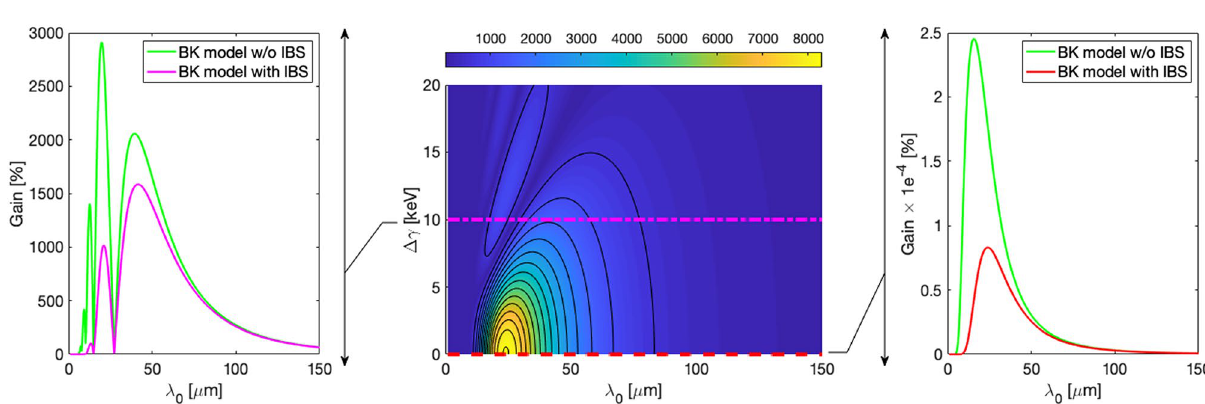
Figure 3. Same as in Fig. 2, but now the gain calculation is at the end of the FERMI